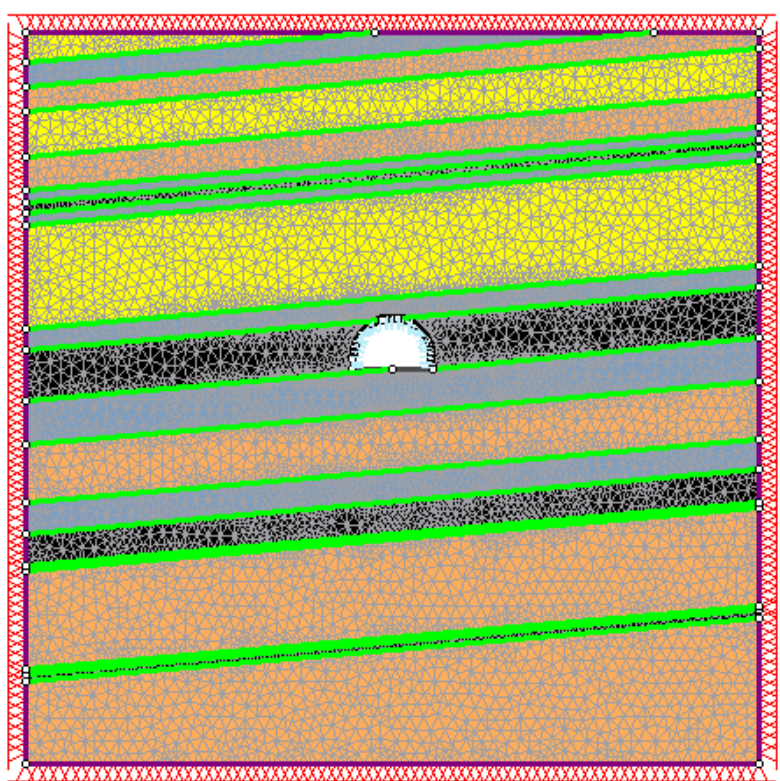
Figure 5. Numerical model section of the roadway D-2.